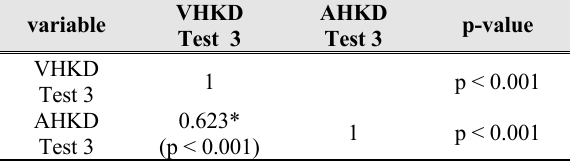
Correlation between VHKD and AHKD (Test 3)